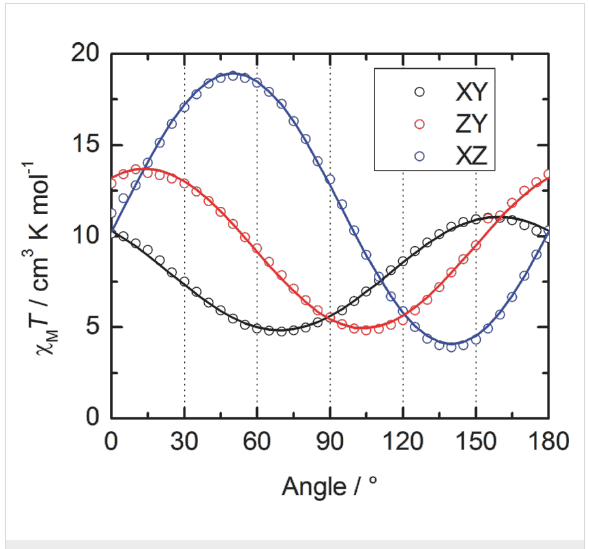
Figure 2: Angular dependence of χ M T measured for Dy1 in the three orthogonal planes with the best fitted curves as solid